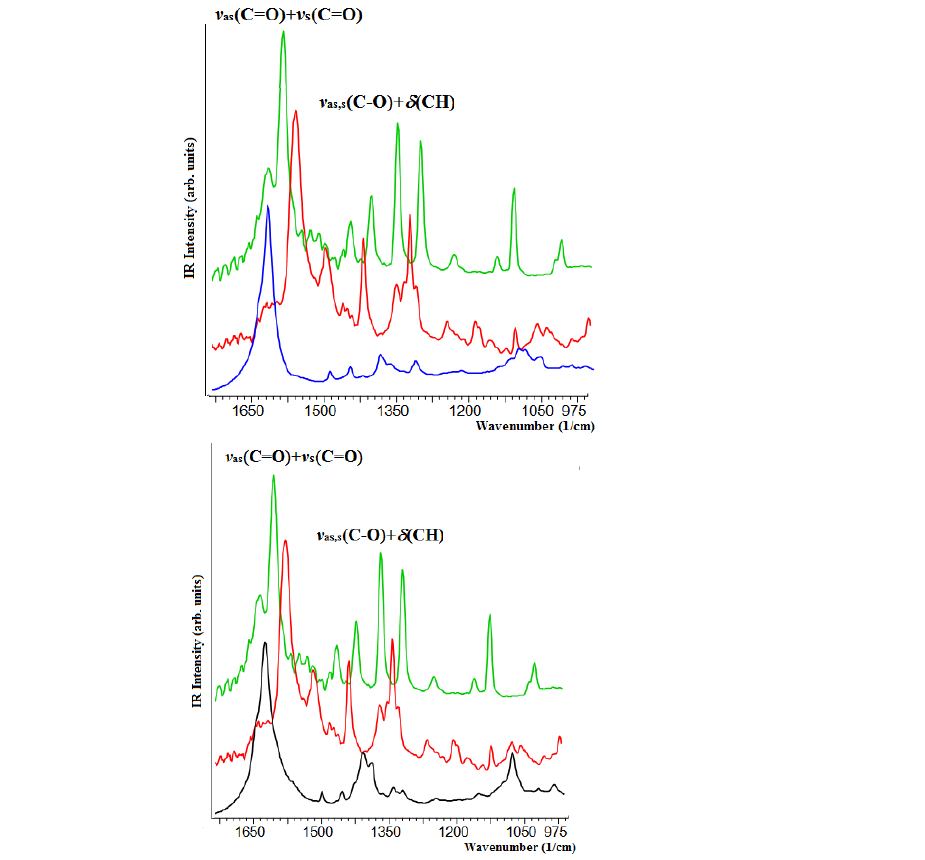
Figure 2. Fragments of IR spectra in the range of characteristic stretching vibrations of S -PheH (green), S -AlaH (red), 1 (blue), and 2 (black). Table 1. Schemes of electrooxidation of the analytes.